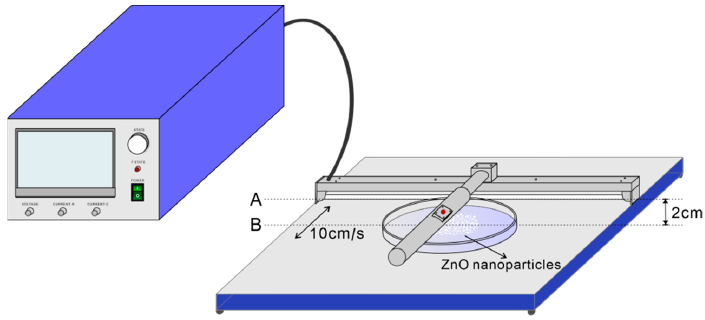
Figure 1. The ZnO NPs were treated by glow discharge plasma equipment.